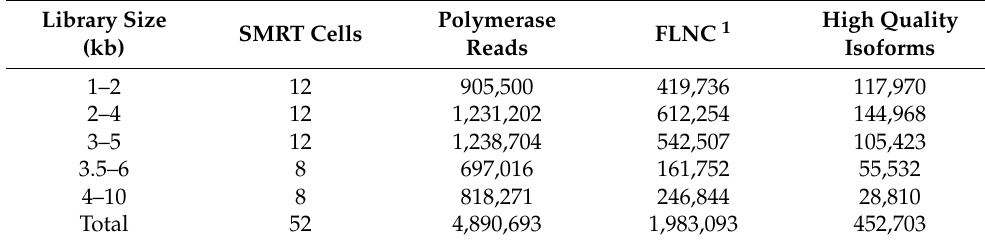
Table 1. Summary statistics of Iso-Seq